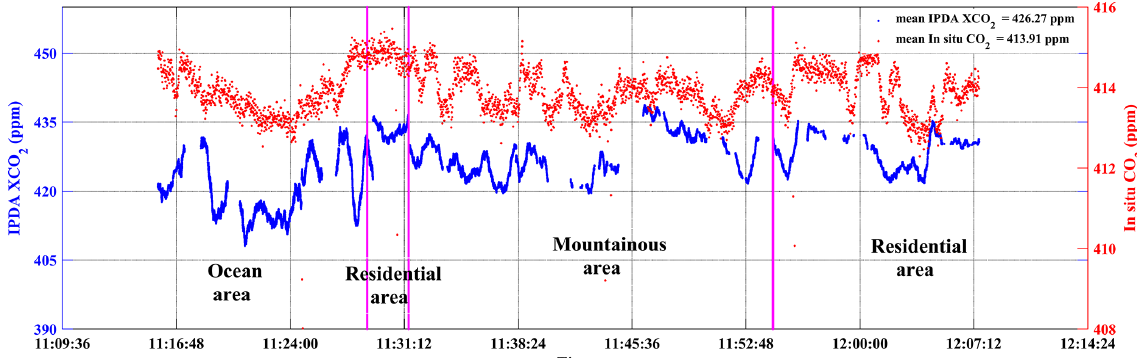
Figure 14. XCO 2 comparison results of airborne IPDA lidar and lightweight ground radar (LGR) on 14 March 2019. The red scatter is the result of greenhouse gas analyser. The blue scatter is measured by airborne IPDA lidar. The purplish red vertical line represents the boundary of different surface types. The plane passes through the ocean area, urban residential area, mountain area, and urban residential area in turn.